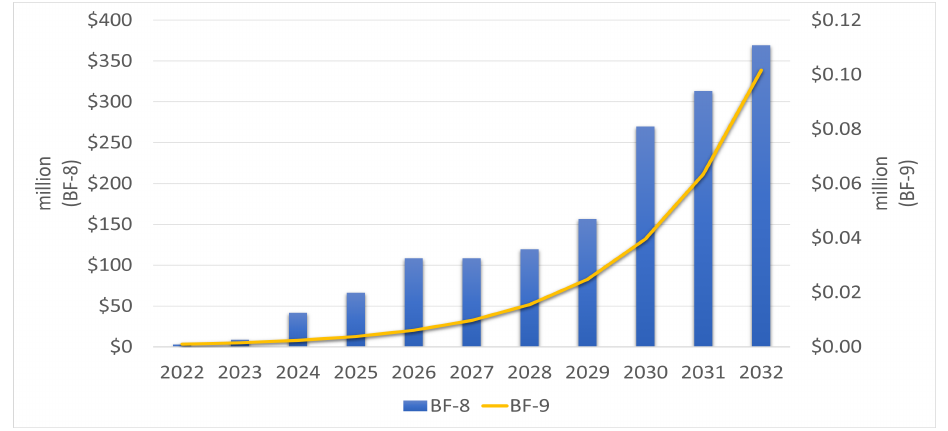
Figure 8. Yearly estimated values coming from BF-8 (see Section 4.8) and BF-9 (see Section 4.9). Finally, Figure 9 displays the net positive gain for society and environment for the next 11 years generated from AAM infrastructure in Ohio. For 2022, the estimated net positive impact (NPI) is $9.74 billion, and following 61.6% CAGR, the gain is estimated to rise at $76.68 billion. We calculated this gain by subtracting the CAPEX-OPEX cost (see Figure 3) from the total sum of all the values of the nine benefit factors over the 11 years. For addressing uncertainty in forecasted variables, we considered 95% confidence interval during forecasting each variable and presented the outcome by upper limit, mean and lower limit of NPI in Figure 9.